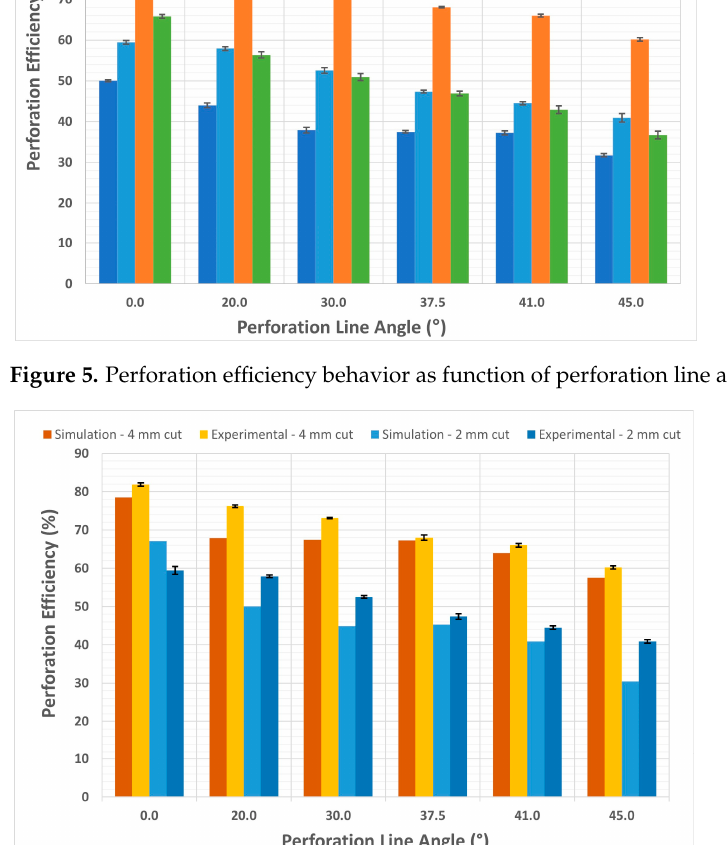
Figure 6. Experimental and theoretical perforation efficiency results as function of perforation line